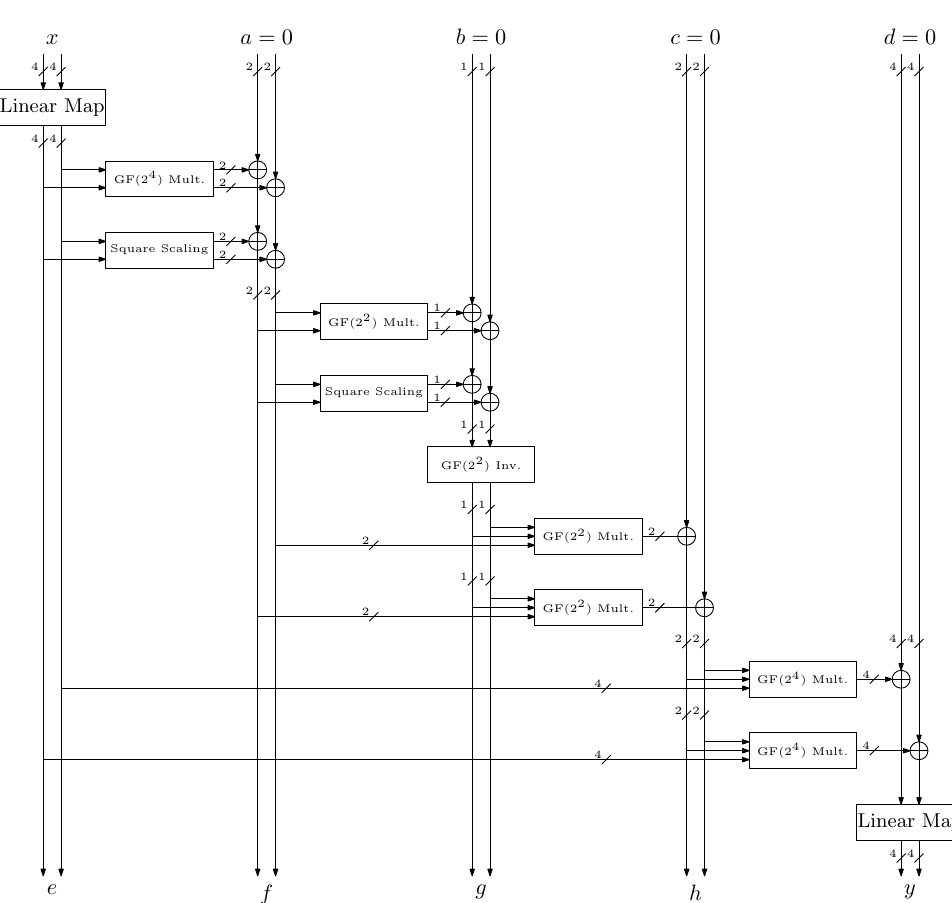
Figure 1: Description of AES S-box ( y = S ( x )) relying on invertible computations. The arguments for the security and fault propagation of p TS are analogous to Section